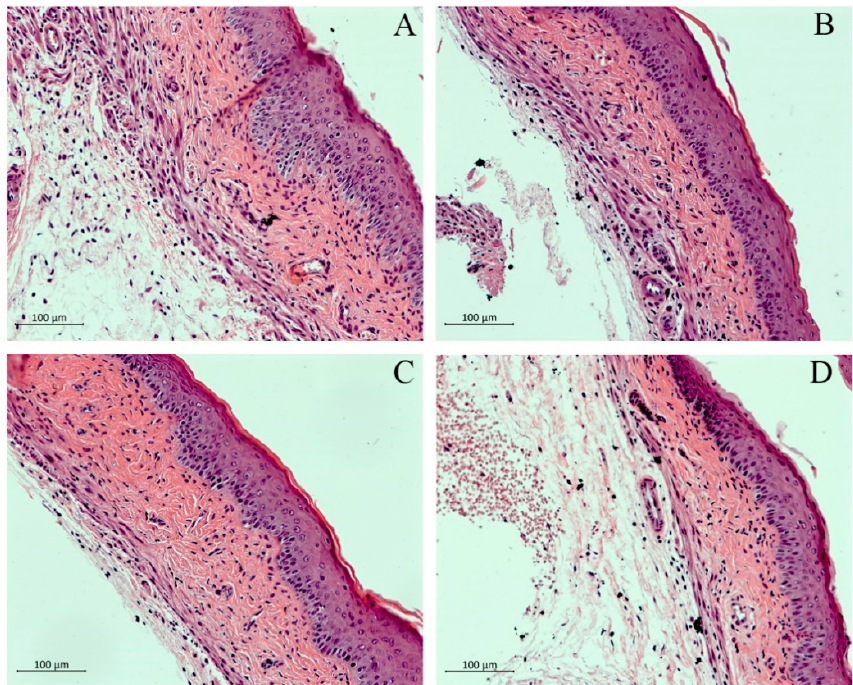
Figure 3. Histopathological analysis of vaginal tissues with H & E staining. Mouse vaginal tissue was excised longitudinally, fixed in 10% neutral-buffered formalin, and then embedded in paraf- fin. Each section of paraffin-embedded tissues was stained with H & E and then observed using alight microscope. ( A ) Naive group, ( B ) Blank, ( C ) CAR (50 mg/kg), and ( D ) WSCP1 (50 mg/kg). Magnification: 400×; scale bars, 100 μ m.